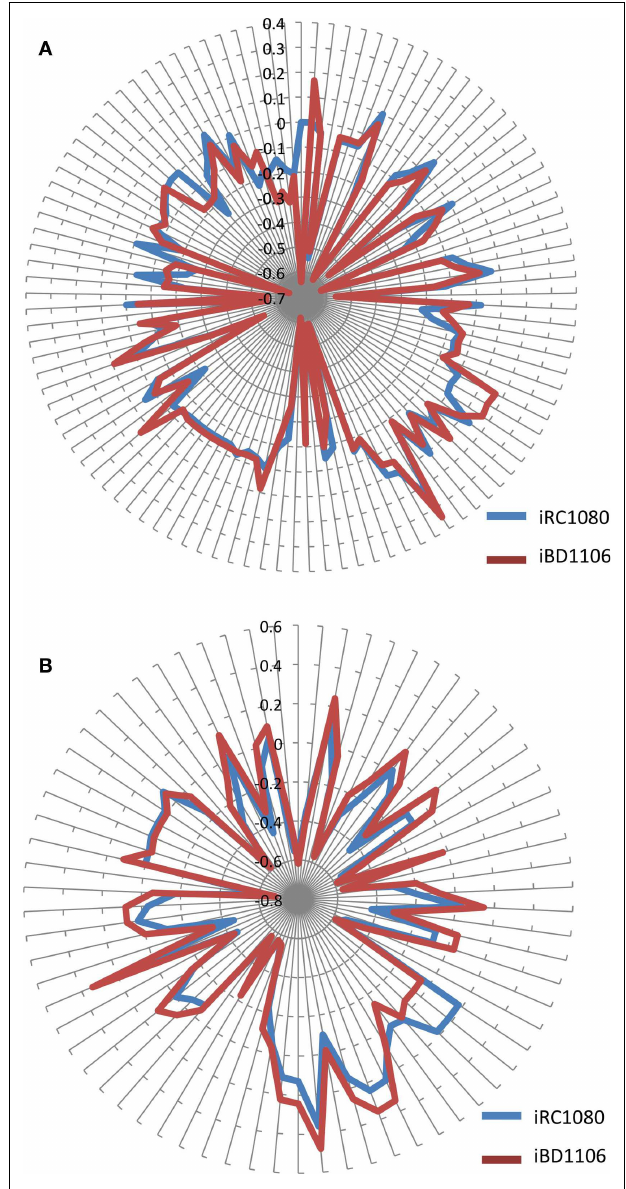
FIGURE 5 | Shadow prices of metabolites in iRC1080 and iBD1106 under different conditions for biomass maximization . Each circle on the “radar plots” corresponds to a shadow price value, while each line extending from the center of a plot indicates a metabolite. (A) shows the different shadow prices and subsequently metabolic behaviors of iRC1080 and iBD1106 under light growth conditions, while (B) shows the different metabolic behaviors of metabolites of iRC1080 and iBD1106 under dark growth conditions.